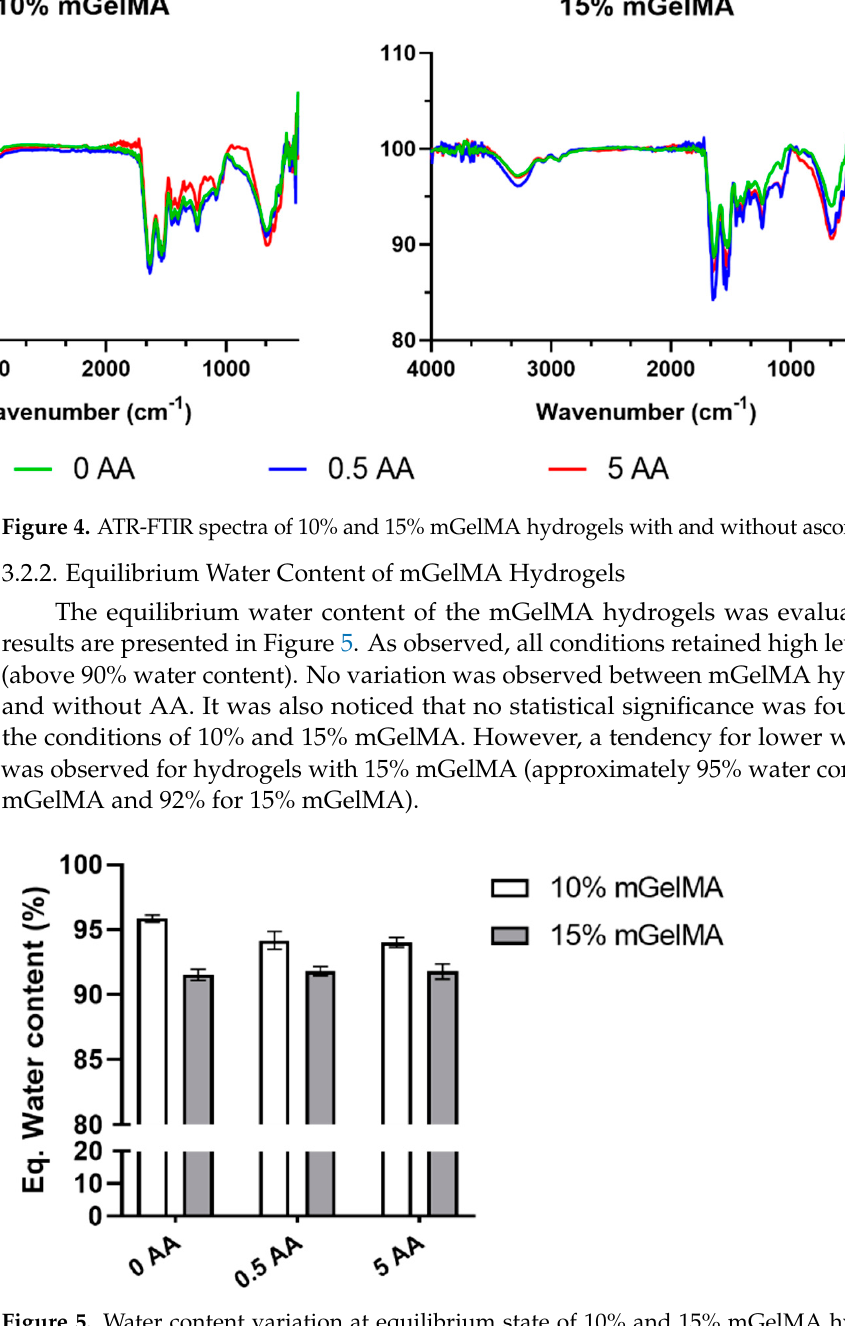
9 of 24 Figure 3. Summary of codfish mGelMA hydrogel assembly. ( A ) Schematic representation of hy- drogel production with or without HK cells. ( B ) Representative scheme of the reaction between codfish mGelMA polymer and the photoinitiator to obtain crosslinked hydrogels.